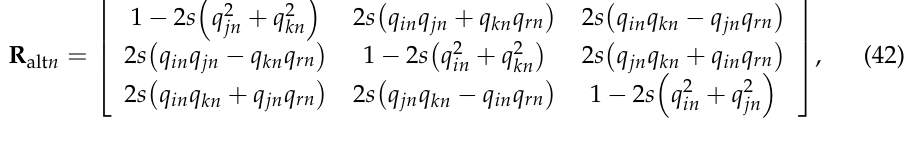
The quaternion formula for vector rotation is